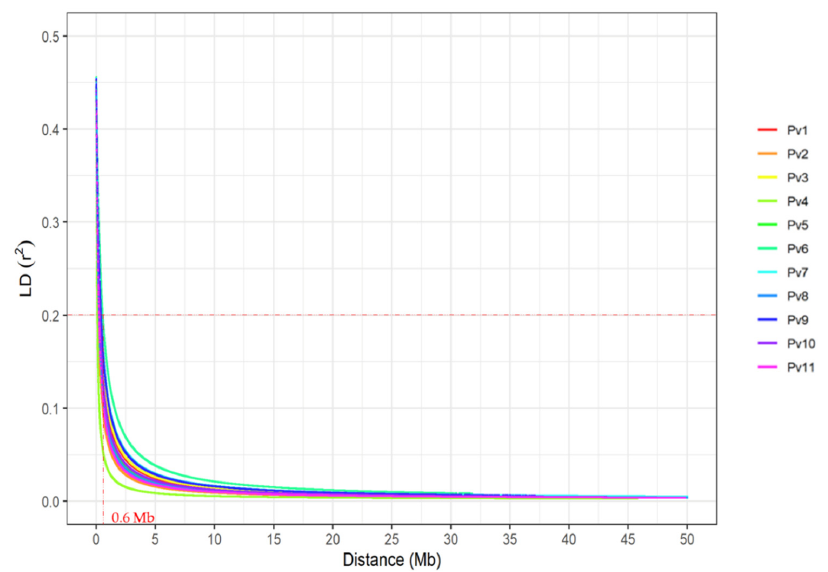
Figure 3. Linkage disequilibrium (LD) decay determined by the LD measurements (r 2 ) based